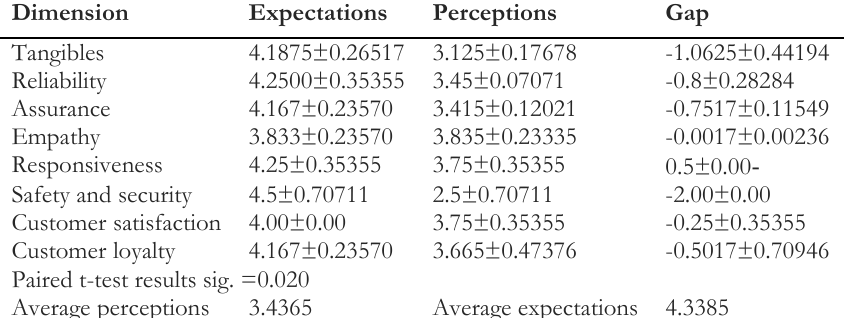
Table 4. Gap quality analysis of reverse support services - unit